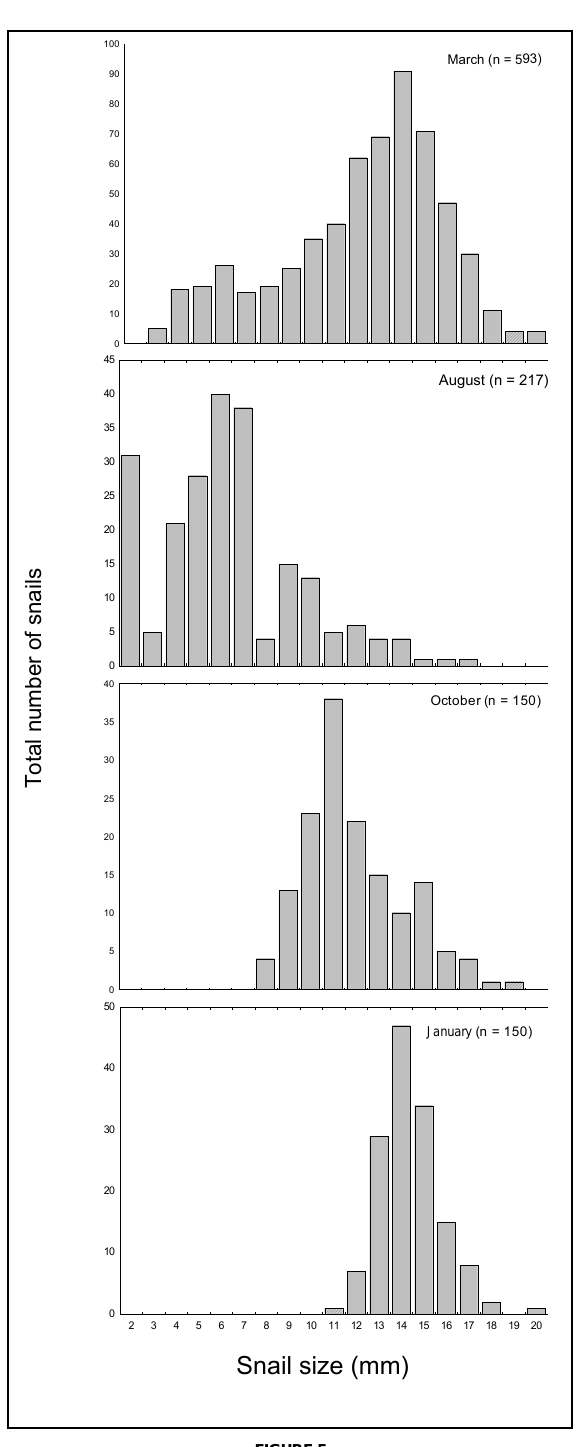
Figure 5 Size frequency distributions of Theba pisana in the WCNP in March, August and October 2006 and January 2007